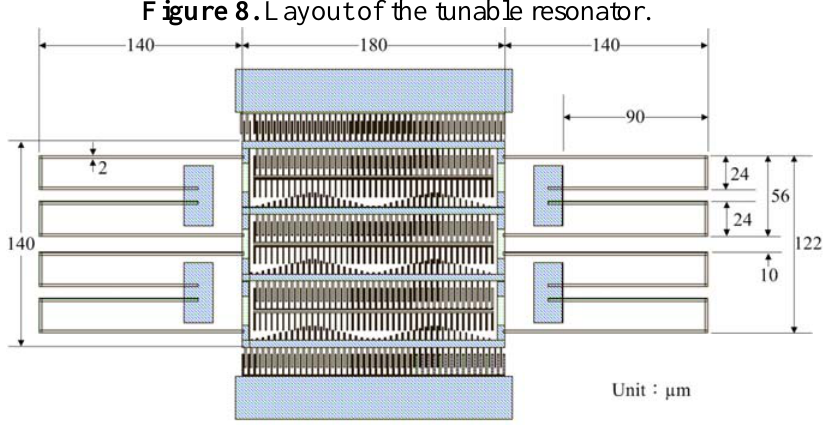
Figure 8. Layout of the tunable